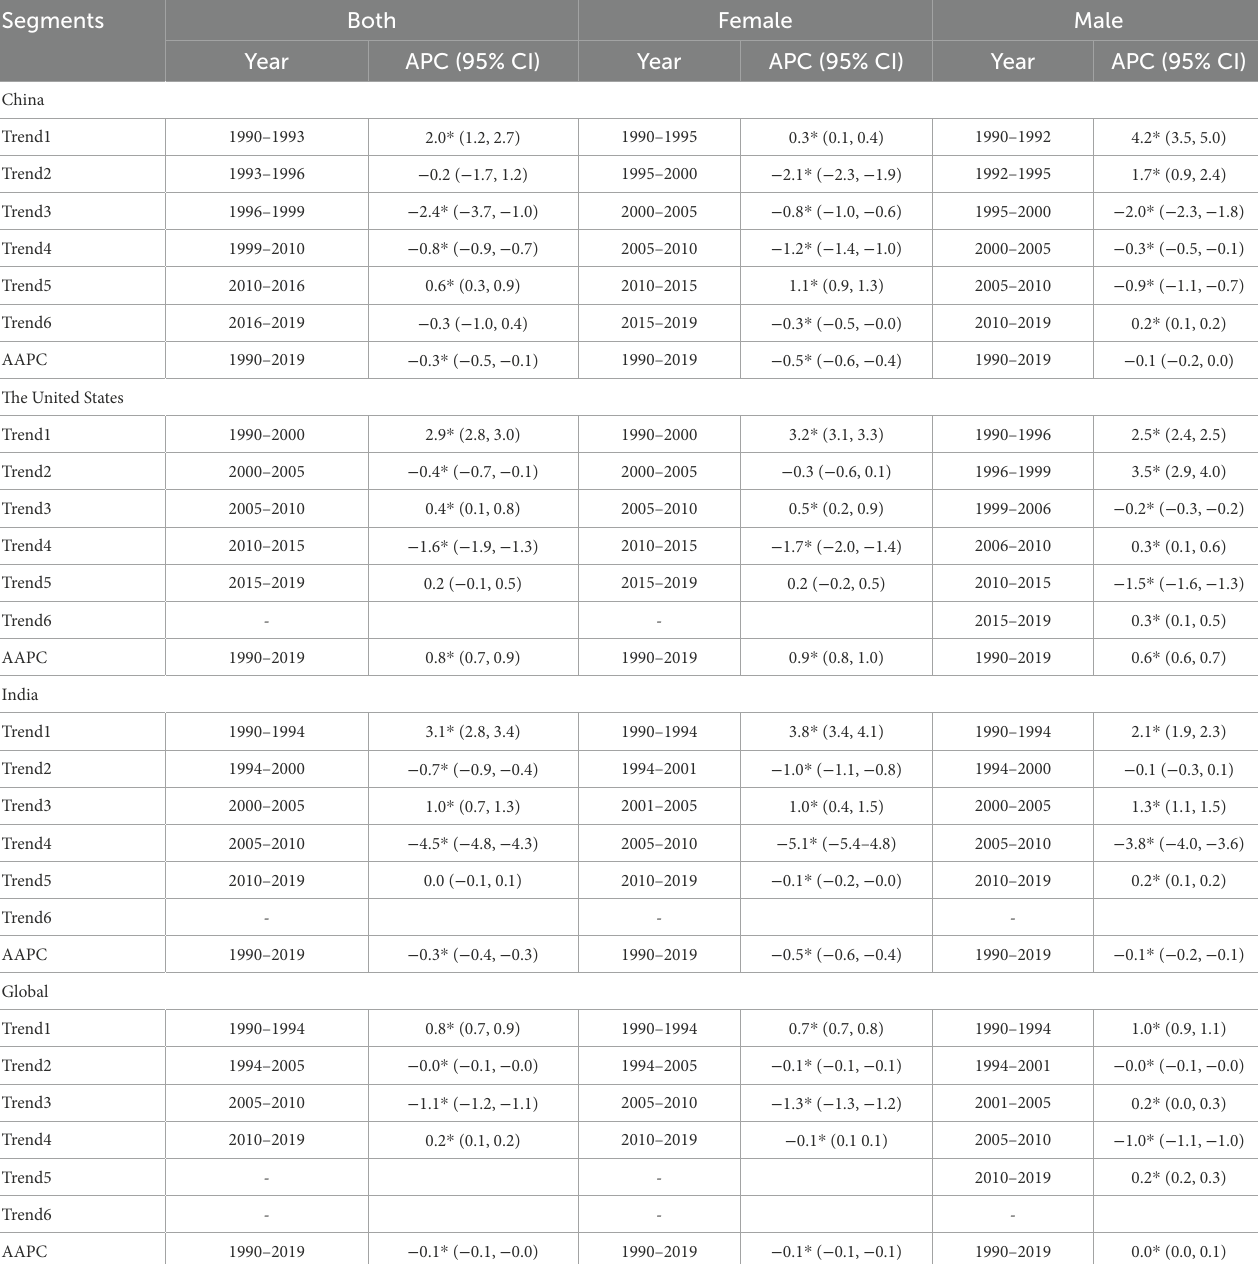
TABLE 1 Trends of age-standardized incidence rates for mental disorders in the whole population, males and females in China, the United States, India and the global, 1990 to 2019. Segments Both